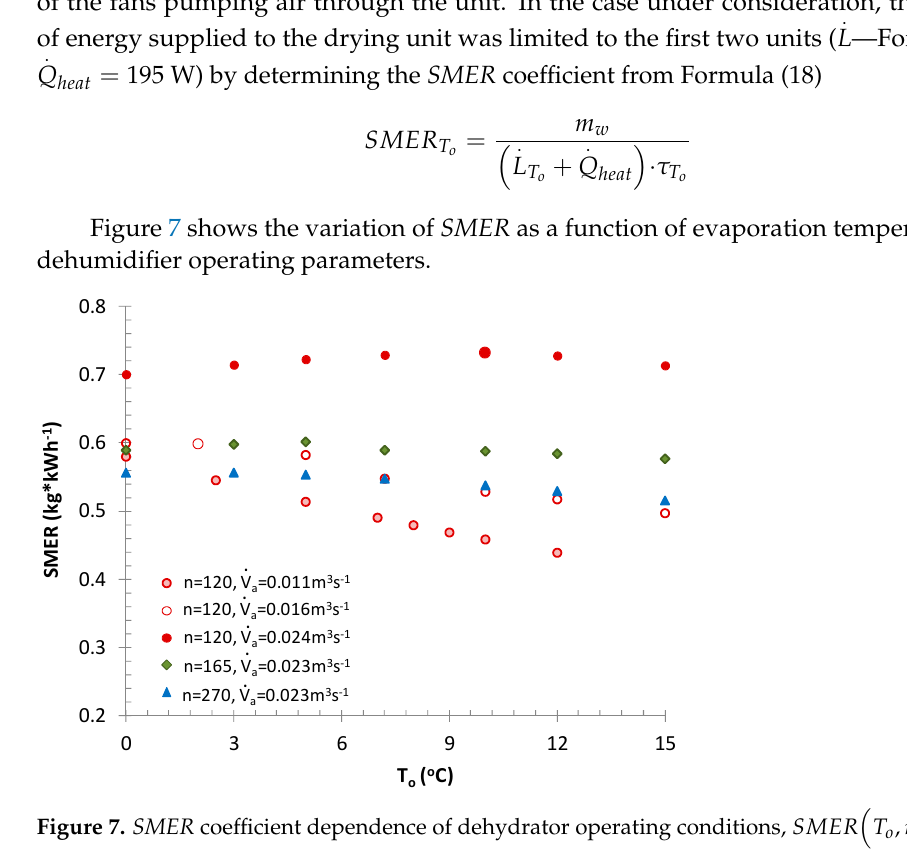
coefficient dependence of dehydrator operating conditions, SMER